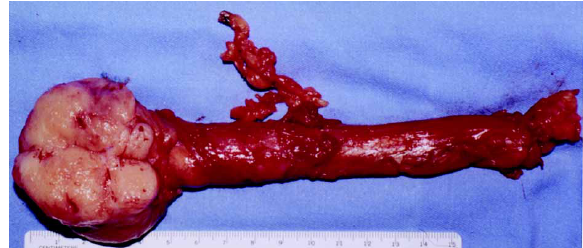
Figure 2 – Surgical specimen of left side. Note the minimal thick- ness of normal tissue in the testicle periphery.